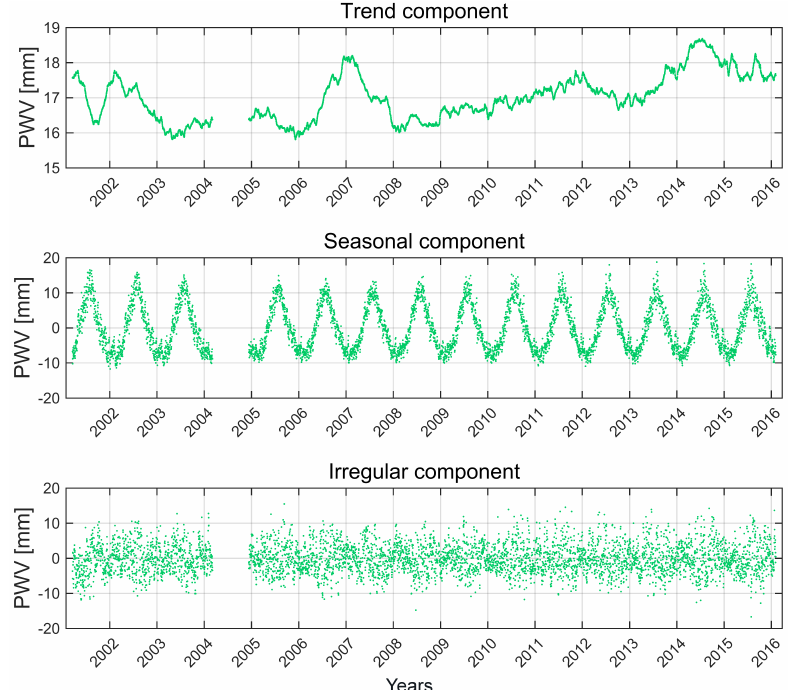
Figure 5. Trend, seasonal, and irregular components of PWV time series estimated from GNSS observations (2001–2016) at the site 0896 (Berlin, Germany; 68.37ma.m.s.l.).